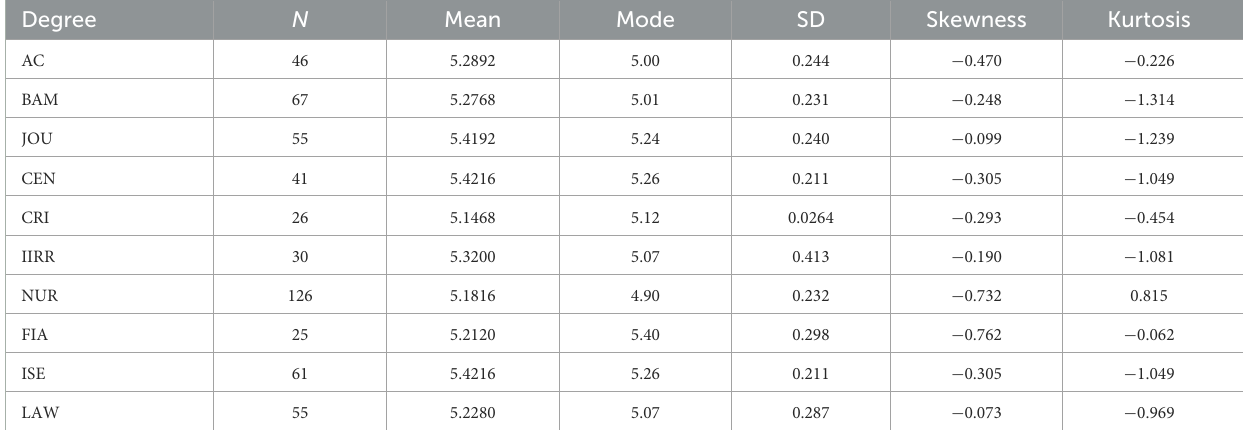
TABLE 3 Distribution of the 532 students with degrees, including in this study participated in the final survey related to the mentoring program (2020–2021). Degree N Mean Mode SD Skewness